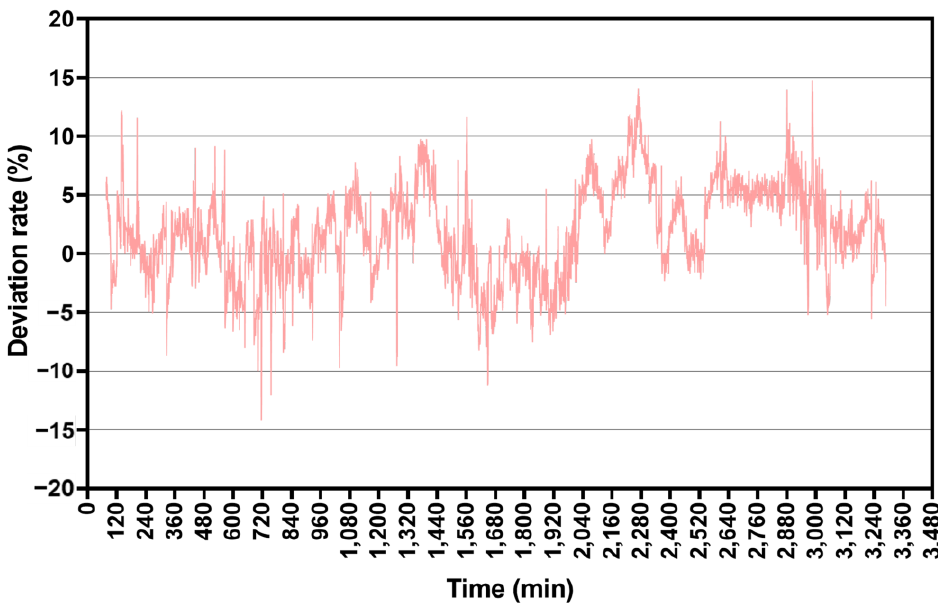
Figure 6. Predicted deviation rate of sulfur content of ship fuel during the voyage.